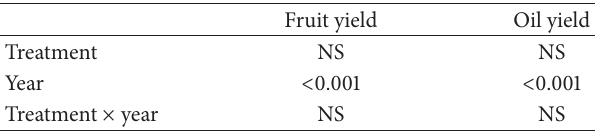
Table1:Repeated-measuresANOVAtable(prob. > 𝐹 )forfruityield per tree and oil yield per ha for the three years ( 𝑛 = 10